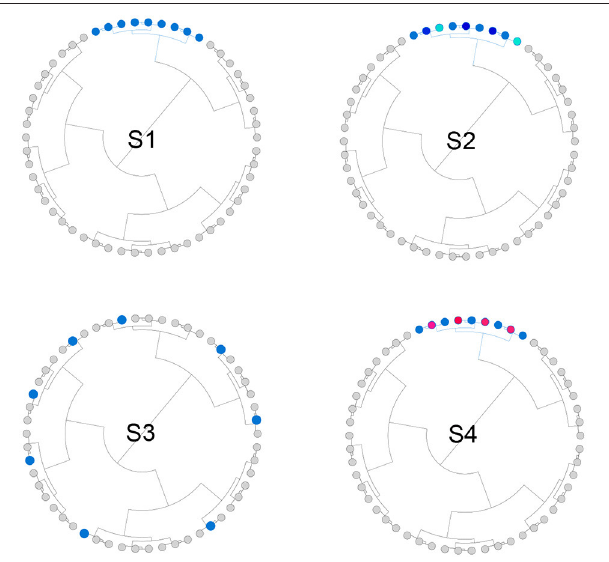
FIGURE 2 | Illustration for the simulation strategy. We simulated both phylogeny-informative scenarios (S1 and S2) and phylogeny-non-informative scenarios (S3 and S4). Blue and red color indicate the direction of the effect while the darkness of the color indicates the magnitude of the